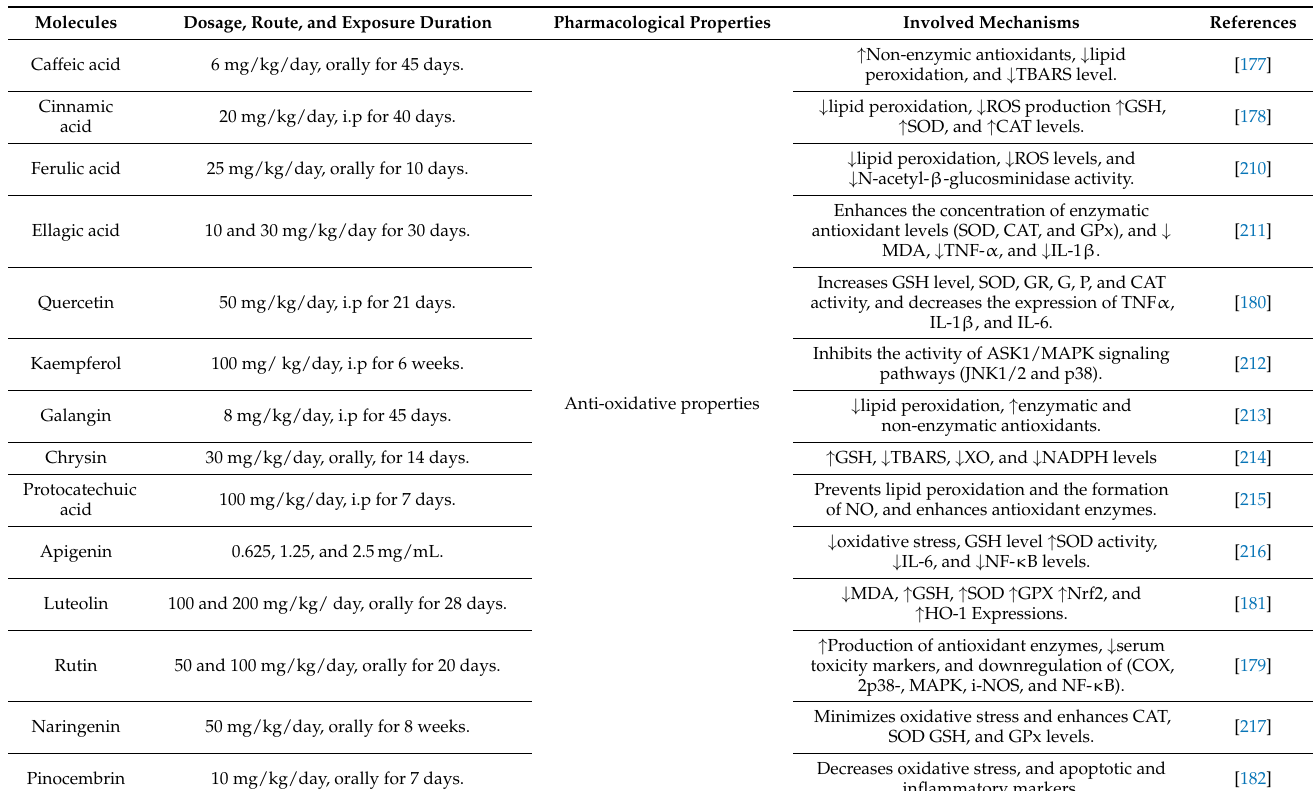
Table 4. Summary of the different pharmacological properties of different phenolic compounds found in bee